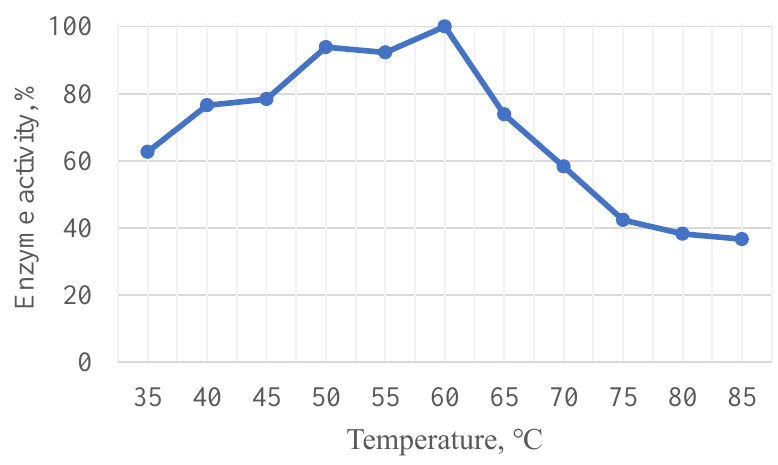
Figure 1. pH optimum for xylanase xAor.